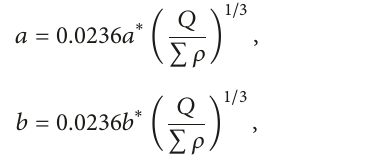
Figure 2: The bearing system model.